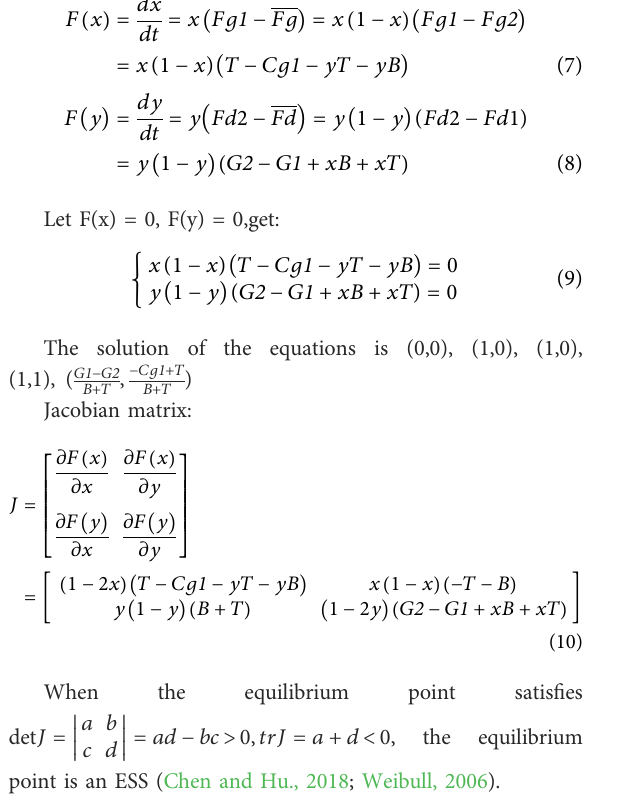
point is an ESS (Chen and Hu., 2018; Weibull, 2006).